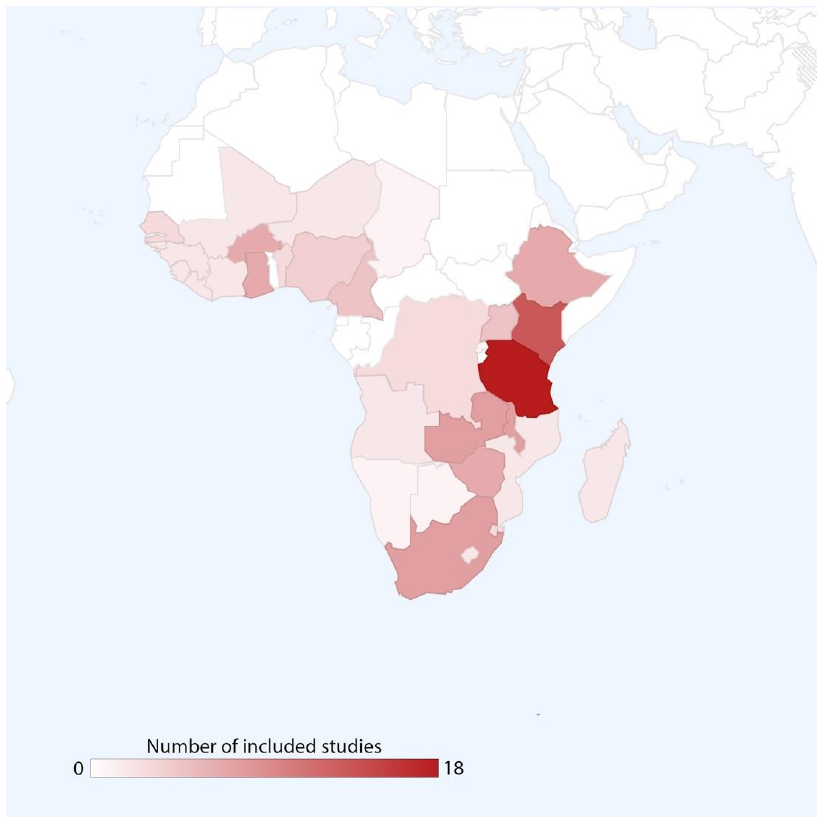
Figure 2. Geographic distribution of included studies (excluding review articles).